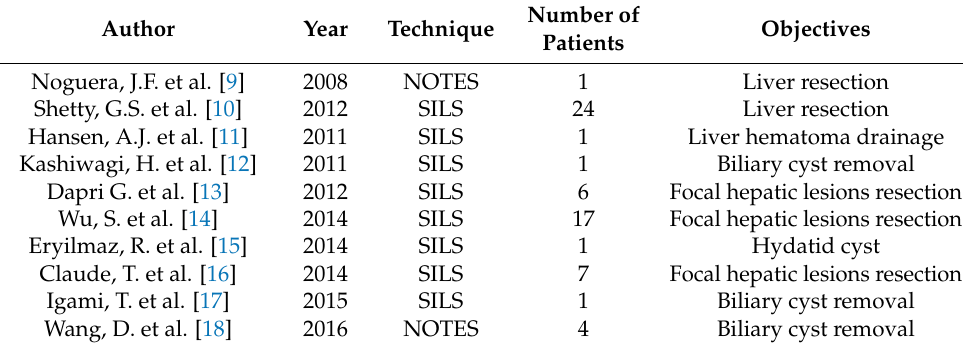
Table 1. General overview of the included studies.